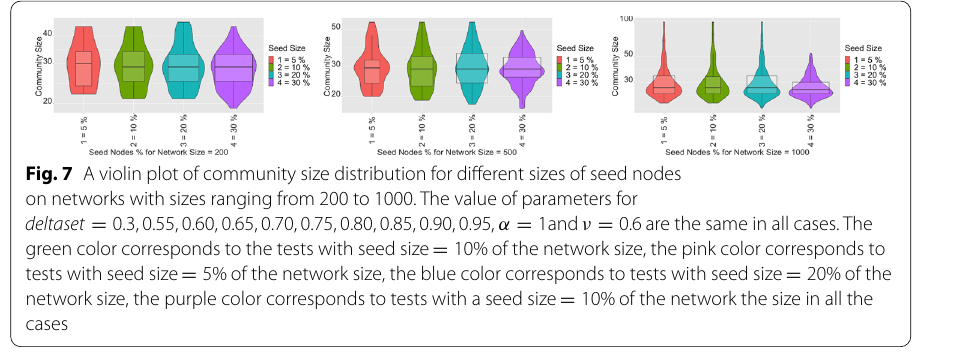
Here, α = 0.75 and ν = 0.6 for all the entries in the table